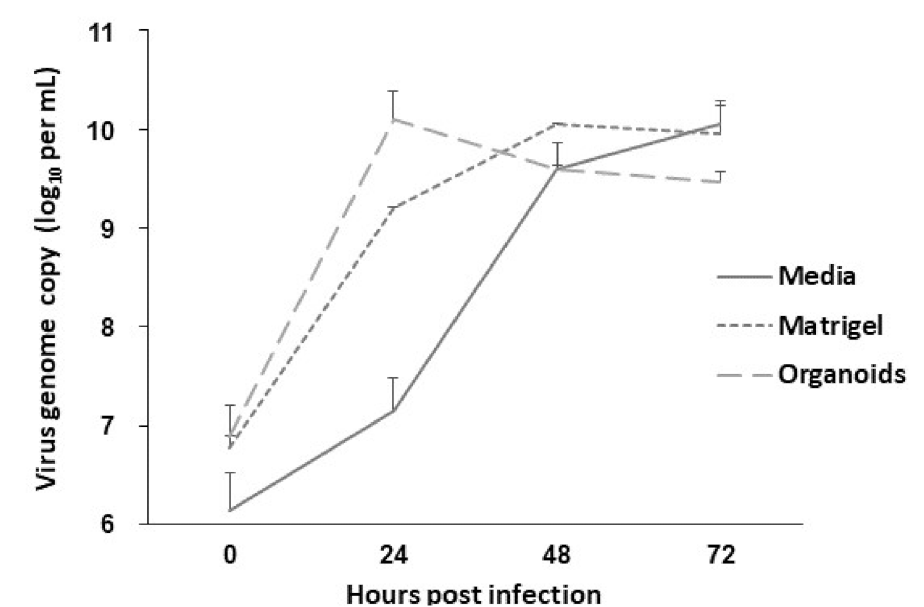
Figure 5. Growth curve of PRV in Matrigel, culture media, and organoids over 72 h. Rousette bat intestinal organoids were infected at MOI = 0.1. The amount of PRV genome was quantified by RT-PCR assay. The infection experiment was performed in technical triplicate, and the quantification of the virus genome was performed in duplicate. The values were shown as the mean ± S.E.M ( n = 3).